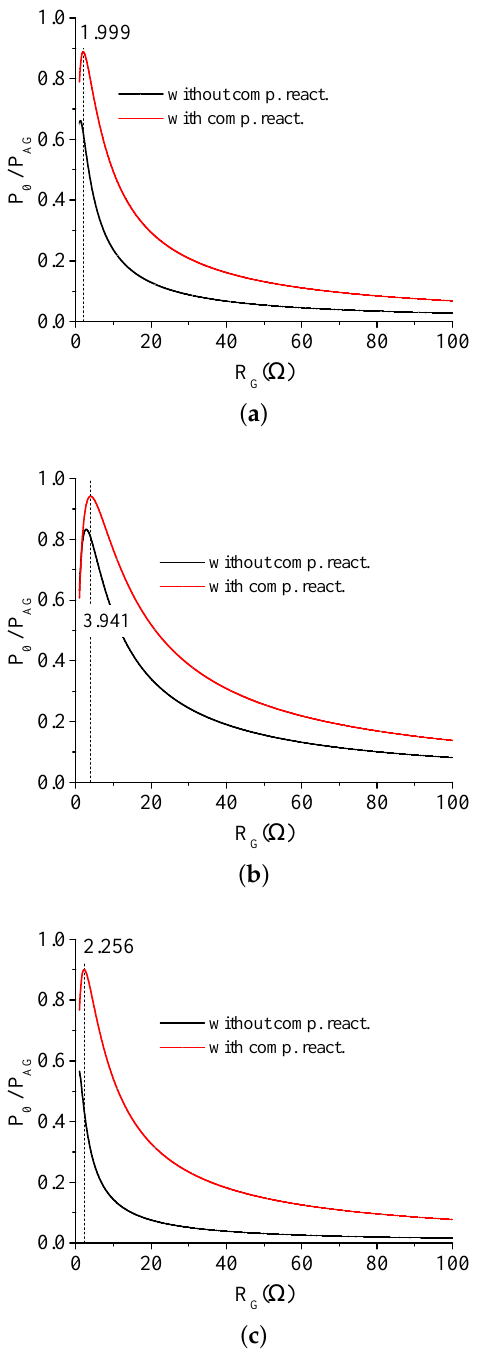
Figure 8. Total output power as function of the generator impedance R G corresponding to the optimal loads Z LM , n = R LM , n + j X LM , n ; results obtained with and without the compensating reactances X LM , n . ( a ) Case 1; ( b ) Case 2; ( c ) Case